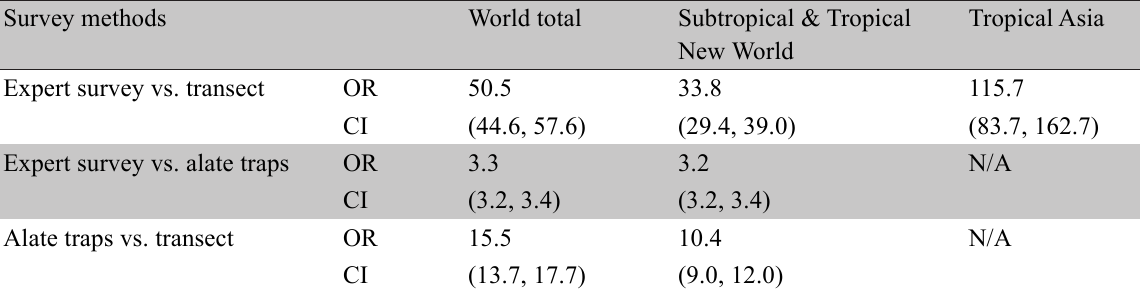
Table 3 . Odds ratios (OR) and their 95% confidence intervals (CI) between different survey methods for encountering a kalotermitid sample. All Odds ratios in the table are significantly different from 1.0